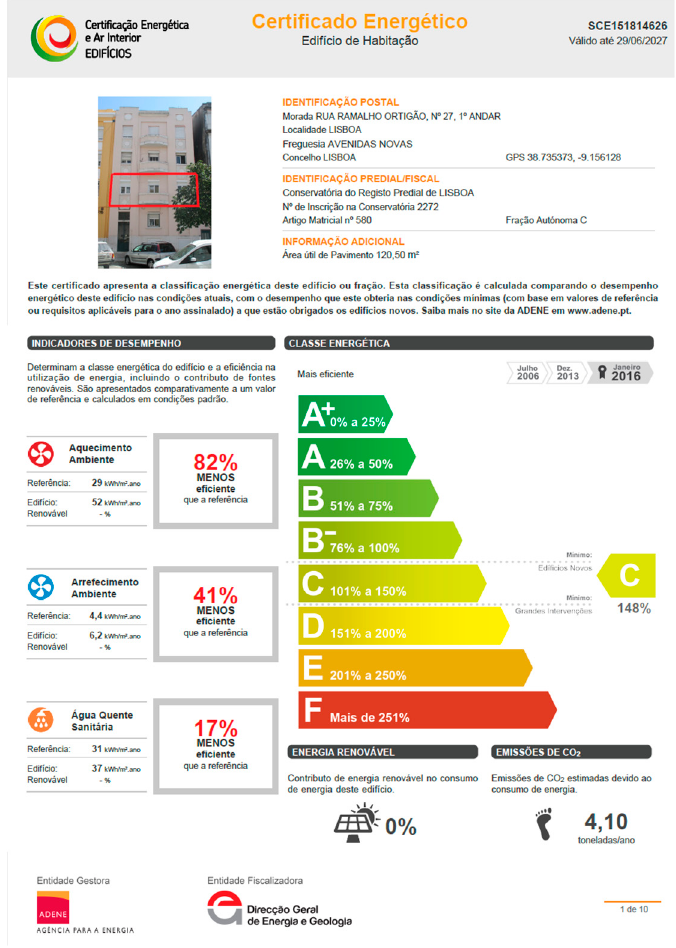
Figure 13. Example of a Portuguese Energy Performance certificate (Ordinances No. 349-A/2013; Order N o . 15793-C/2013).